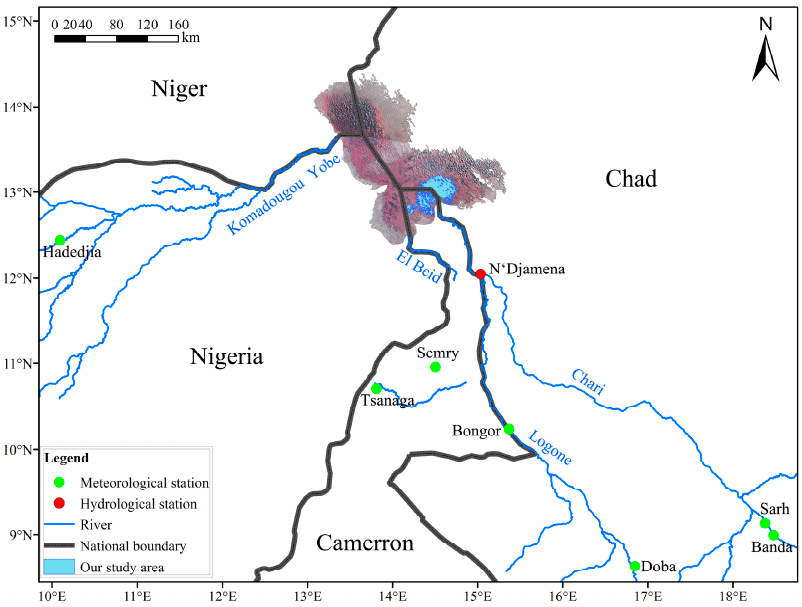
Figure 1. Location of our study area, with its main tributaries and the four riparian countries.